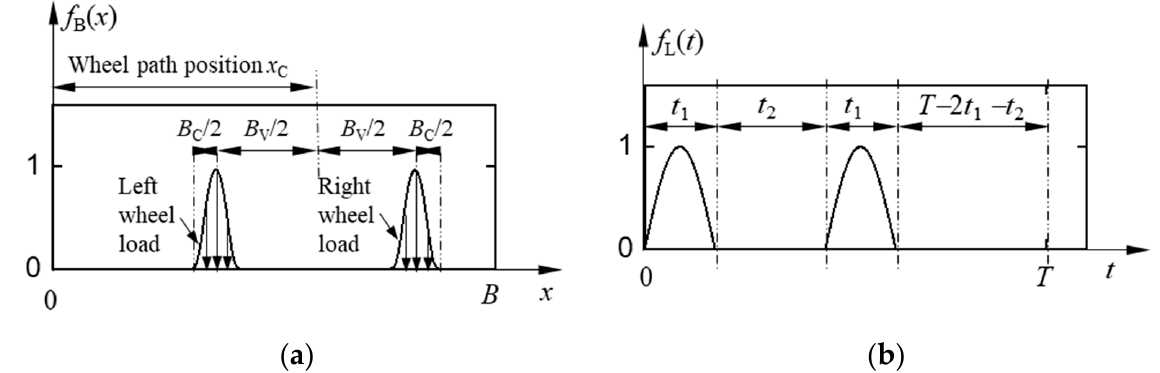
Figure 3. Schematic illustration of the traffic load. ( a ) Distribution of traffic load along the width direction of the road. ( b ) Time-history of traffic load along the driving direction.